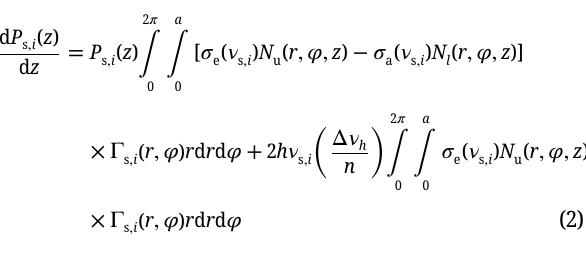
Figure 3: OAM fluorescence emission process in a ring-core active optical fiber. (a) An energy-level structure model of OAM-carrying photons excitation based on the photon–electron interaction: A two-level system of erbium ions consists of energy levels 4 I OAM-carrying photon h 𝜈 at 980 nm is utilized to pump the active fiber, the electrons in erbium ions will be excited from the ground state energy level 4 I to 4 I . Then, the excited electrons will re-transition back to the ground state 4 I 15/2 11/2 amount of photons are released to form fluorescence around 1550 nm and still carry OAM in the active fiber. Especially, topological charge l of the initial photons carried is equal to that of the released photons ( l = − 1, 0, and + 1 correspond to the line in light red, dark yellow, and purple, respectively). (b) Formation and transmission of fluorescence in a vortex field with a spiral phase wavefront in the ring-core active optical fiber: When a vortex pump beam is injected into the active fiber, a vortex field of a ring-shaped distribution will be excited with a spiral phase wavefront. Due to the ring-core structure of the active fiber, a donut-shaped fluorescence emission is